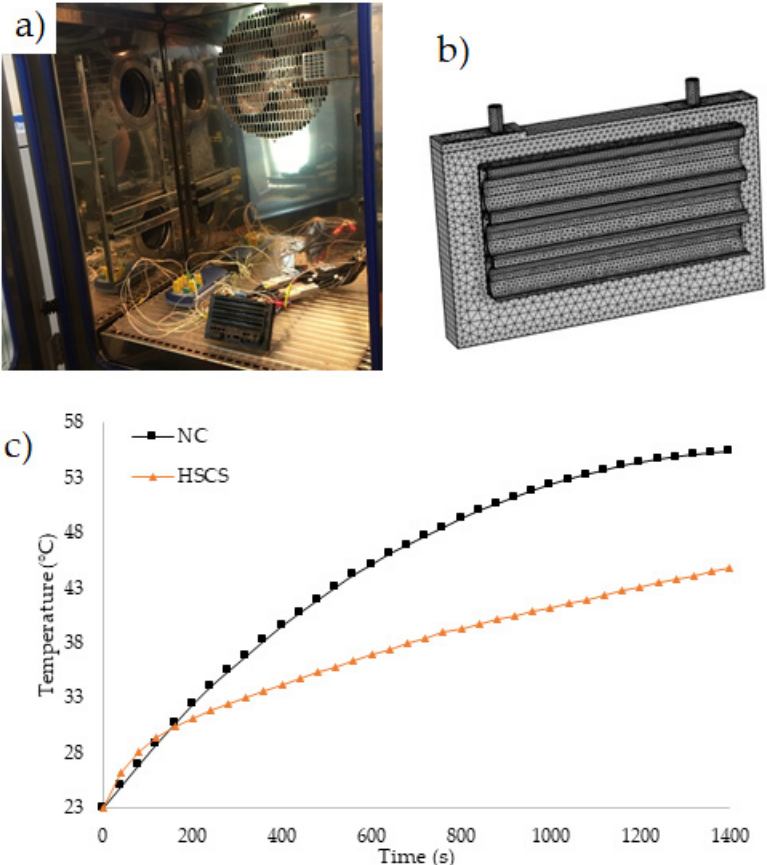
Figure 8. ( a ) Experimental test bench of the heat sink cooling system (HSCS) for the LiC cell; ( b ) 3D model and mesh generation of the system; ( c ) temperature evolution of the heat sink cooling system (HSCS) compared with the natural convection (NC) [34].